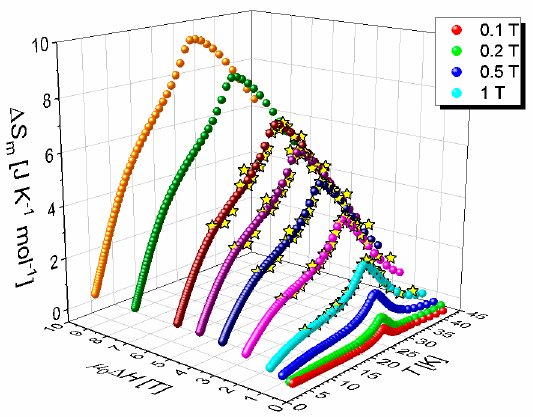
Figure 11. Temperature dependence of the isothermal entropy change Δ S m of 2 inferred from the heat capacity measurements (spheres) or from the isothermal magnetization measurements (stars). Table 2. Peak values of Δ S m and Δ T ad of 2.